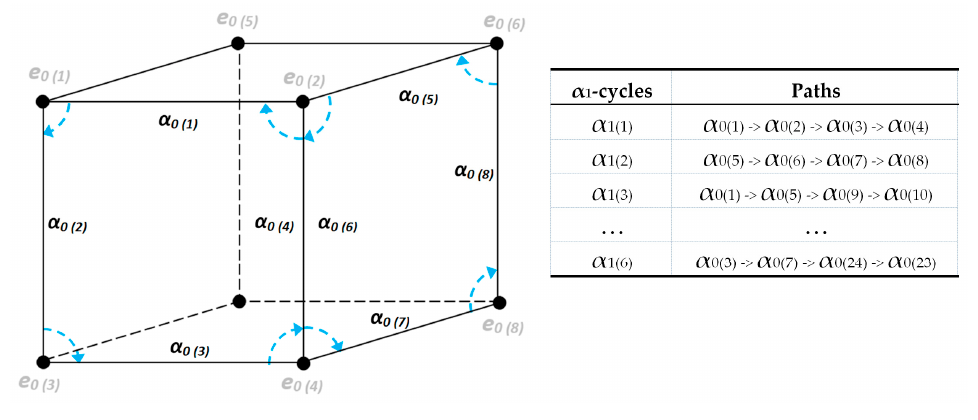
Figure 2: α 1 -cycles and their connectivity